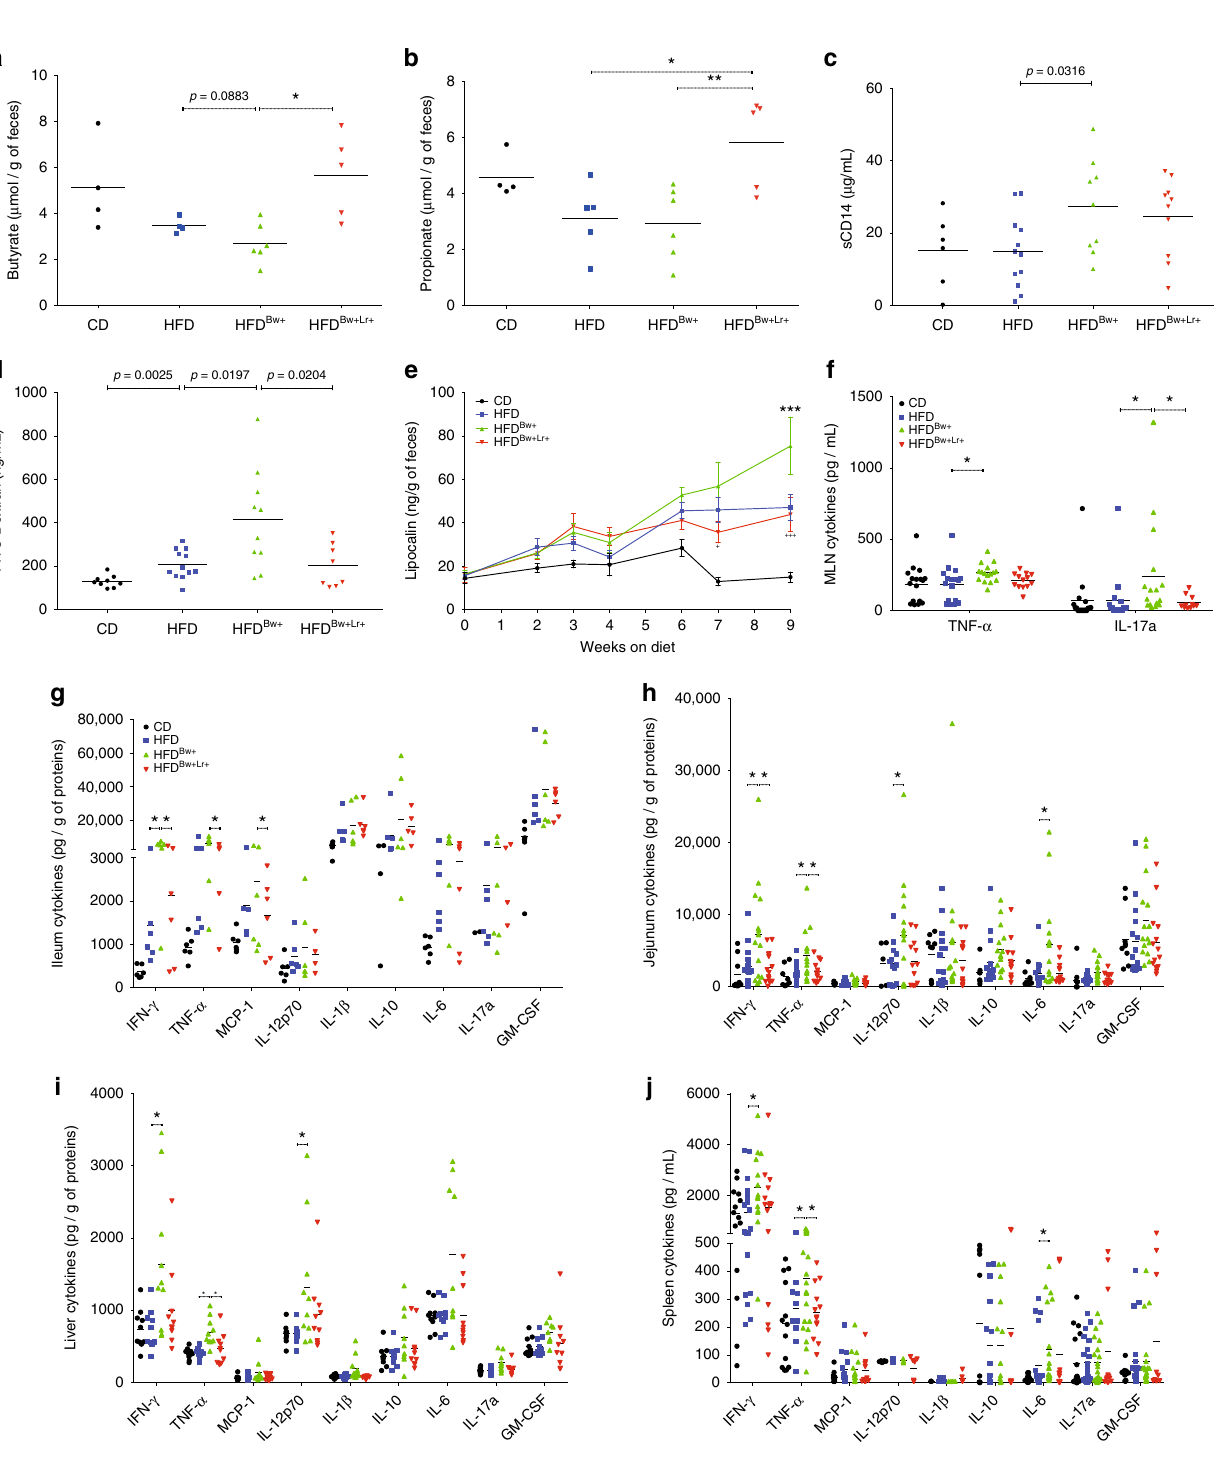
Fig. 7 B. wadsworthia potentiates HFD-induced intestinal barrier dysfunction and in fl ammation. a Butyrate and b propionate concentrations in caecum. c Soluble CD14 (sCD14) in the serum. d Concentration of FITC-dextran in the serum 3 h post-gavage. e Concentration of lipocalin-2 in the feces. f Cytokine production of mesenteric lymph node (MLN) cells after 48 h stimulation with PMA-ionomycin (* p -value vs. HFD, + p -value vs. HFD Bw + ; n = 6 – 16/group). Cytokines level in g ileal, h jejunal, and i liver homogenates (* p -value vs. HFD, + p -value vs. HFD Bw + ; n = 6 – 16/group). j Cytokine production of splenic cells after 48 h stimulation with PMA-ionomycin (* p -value vs. HFD, + p -value vs. HFD Bw + ; n = 6 – 16/group). Statistical comparison was performed by fi rst testing normality using Kolmogorov – Smirnov test and then ANOVA or Kruskal – Wallis test with Bonferroni or Dunn ’ s post hoc test. Error bars represents